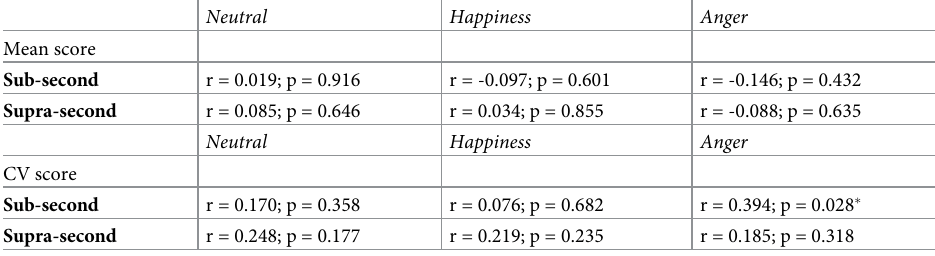
Table 1. Pearson correlation analysis between TAS-20 scores and respective mean reproduction and coefficient of variation (CV) scores.